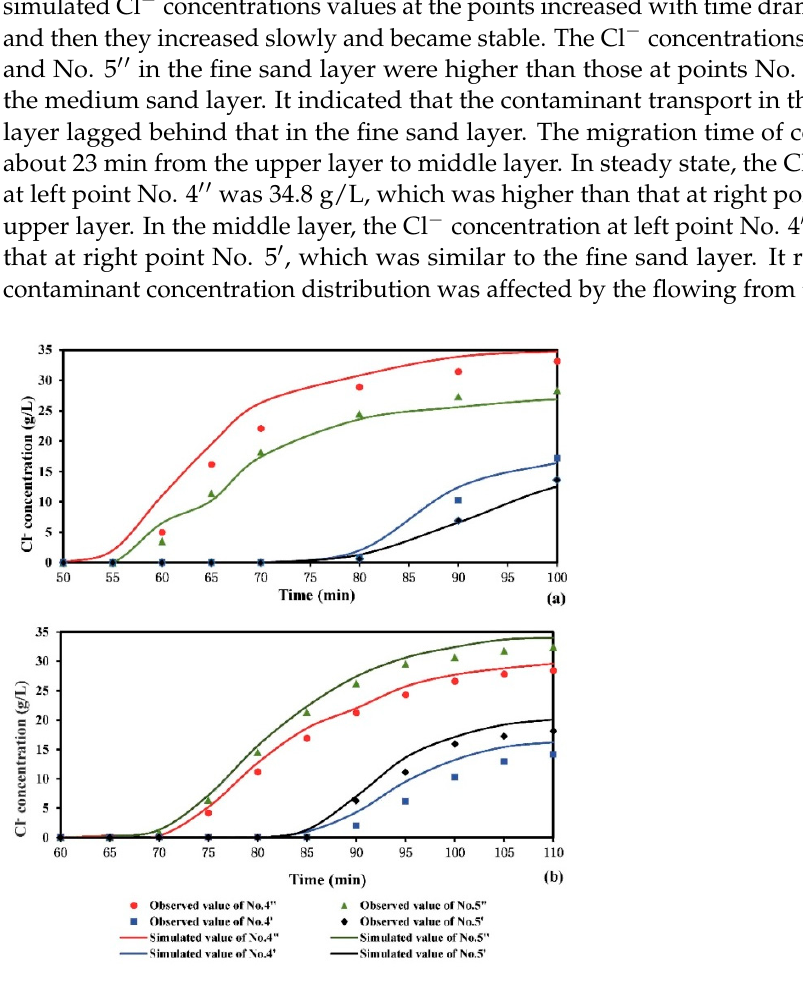
Figure 2. Comparison of simulated and observed Cl − concentrations over time at selected observation points (No. 4 ′ , No. 5 ′ , No. 4 ′′ and No. 5 ′′ ) for ( a ) scenario 1 and ( b ) scenario